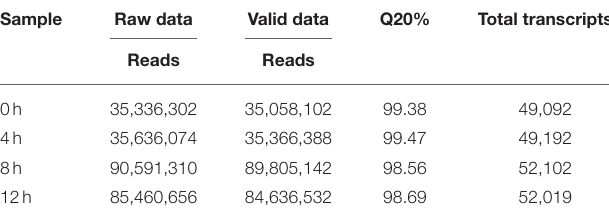
TABLE 1 | The results of transcriptome sequencing data.